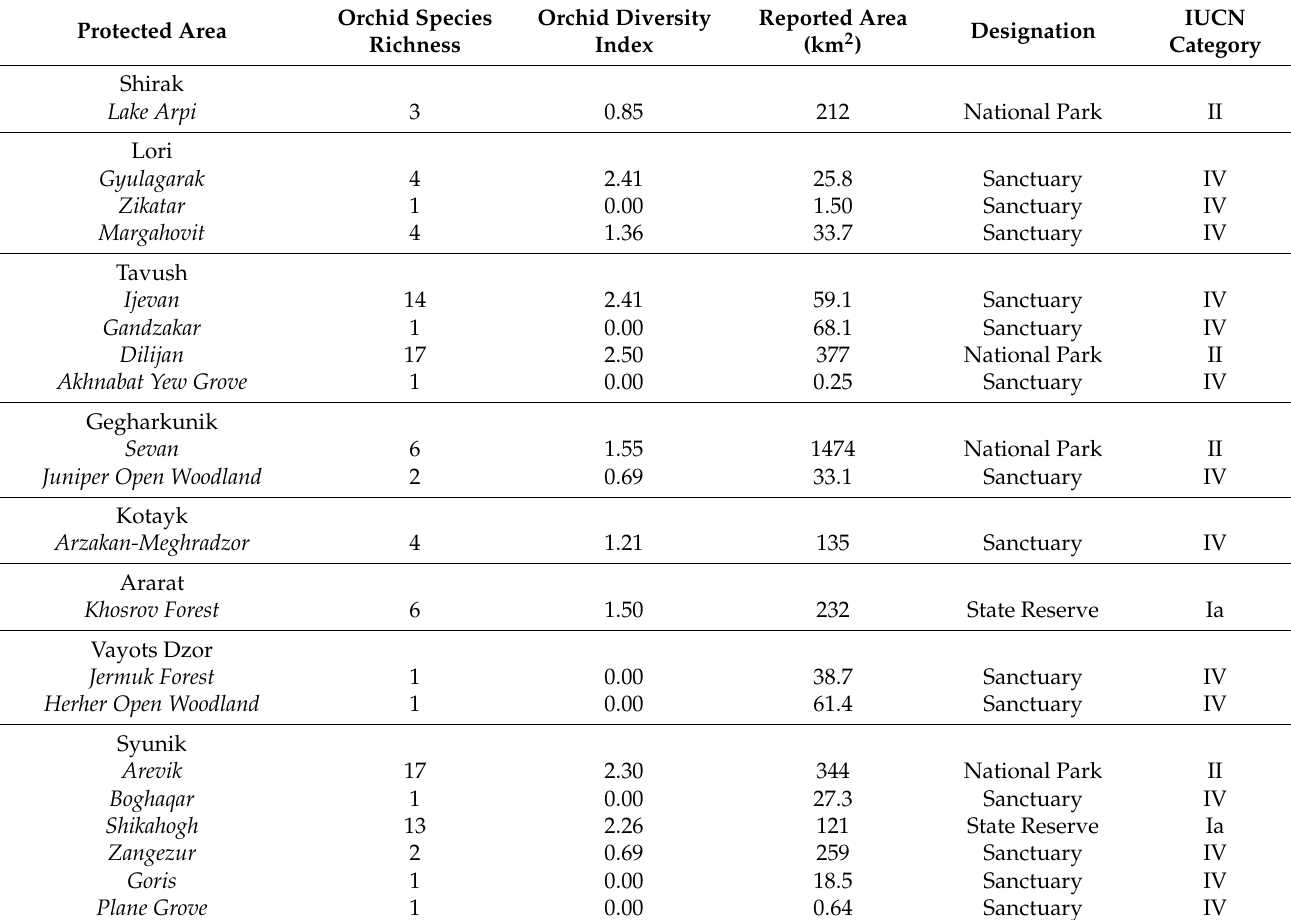
Table 1. Orchid species richness, diversity (Shannon–Weiner Index), area and designation of Protected Area (PA) site found within the territory of Armenia listed by province from north to south. Number of species per PA was calculated using the georeferenced data from herbarium vouchers, field visits and GBIF records. Shannon–Weiner Index was calculated using the “vegan” package [49] in R statistical software [50]. PA names, their reported area and designation are from the World Database of Protected Areas, downloaded from the Protected Planet website